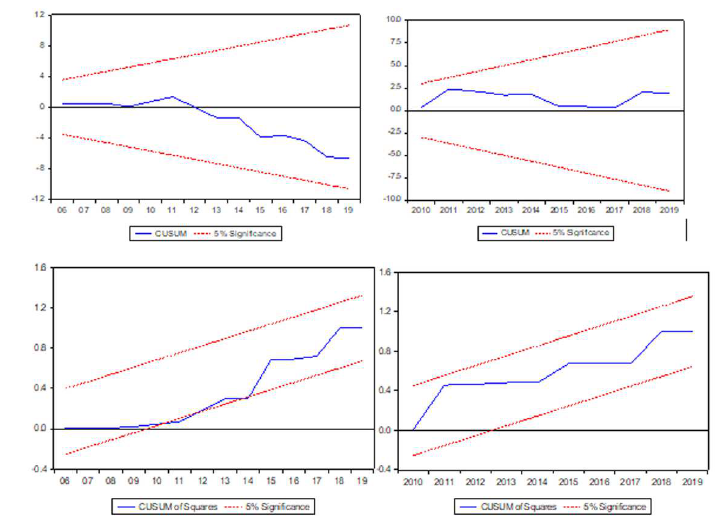
Figure 3. CUSUM and CUSUM of Squares Stability Tests – Model I and